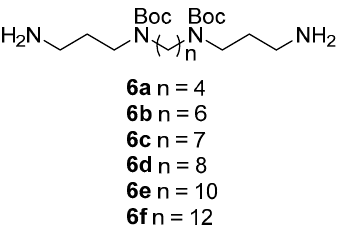
Figure 3. Boc-protected polyamines 6a – f .